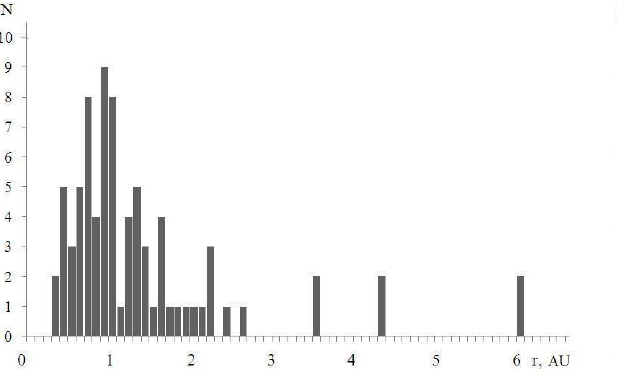
Figure 3. The dependence of the number of comets N with an anomalous tail on the heliocentric distance r .